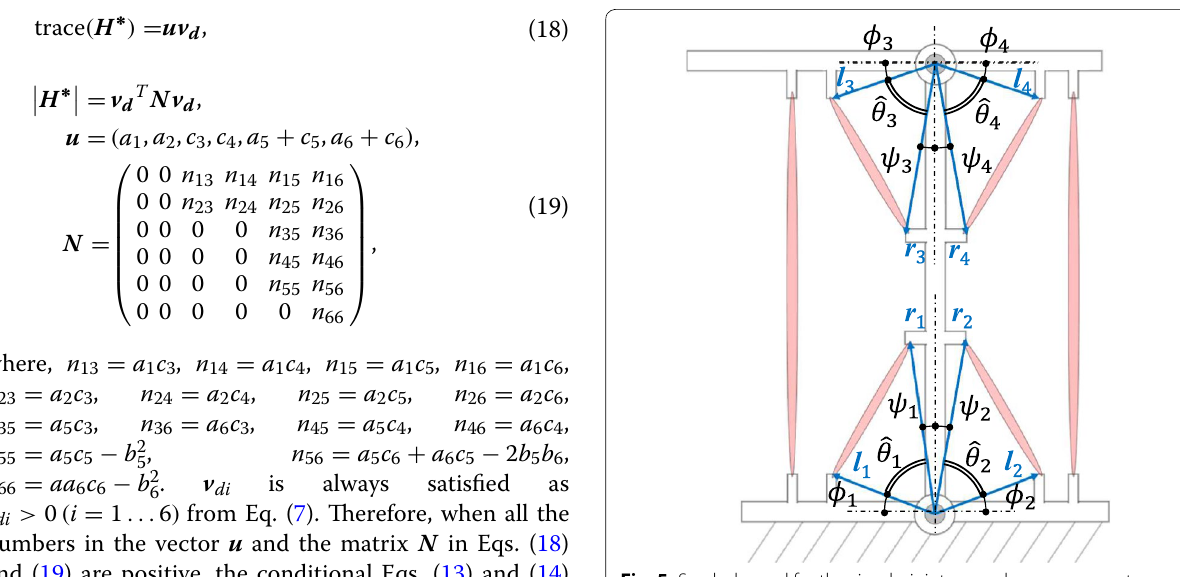
Fig. 5 Symbols used for the simple-joint muscular arrangement